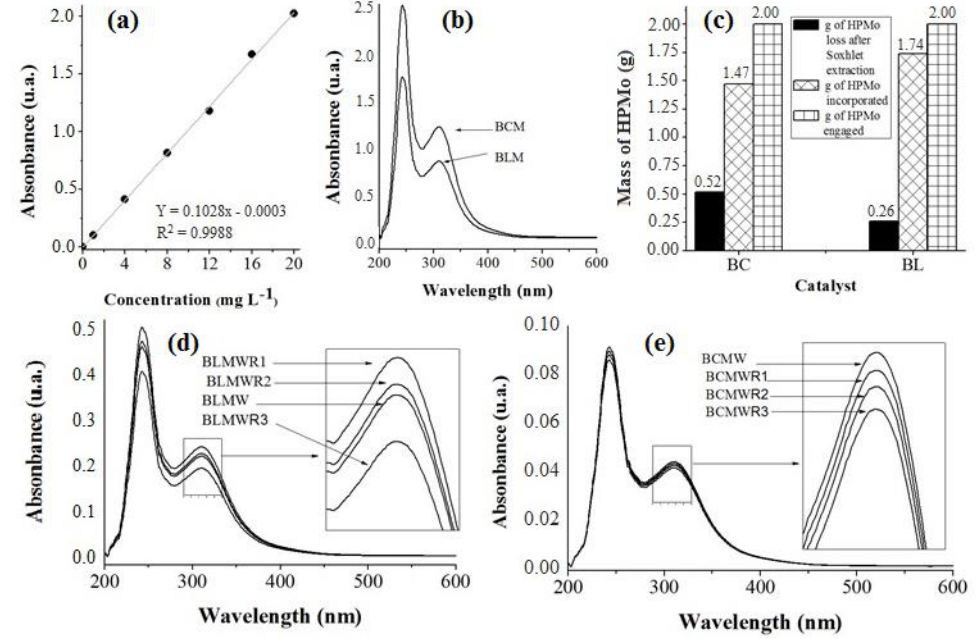
Figure 1. ( a ) Calibration curve for determination of the leaching of the catalysts supported